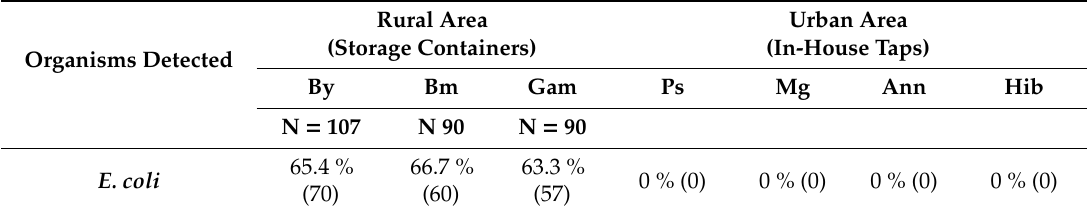
Table 6. Prevalence rates of E. coli detected in drinking water samples after sequencing of 16S rRNA genes (N = 287 selected samples, between January 2008, November 2009 and April 2015).